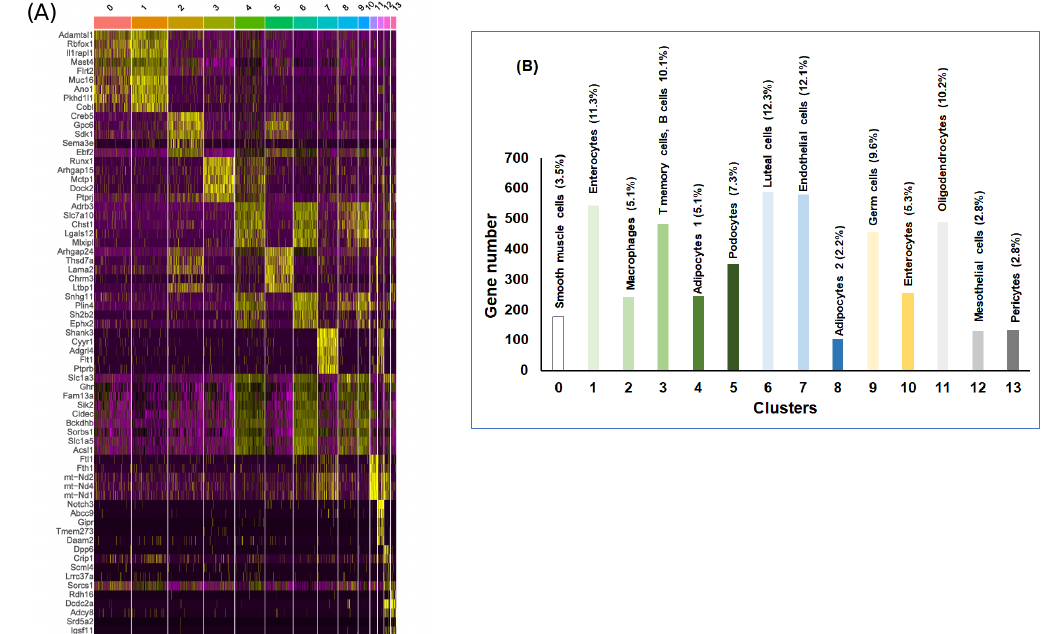
Figure 2. snRNA-seq for the statistically significant differentially expressed genes (DEGs) in vWAT of mice exposed to RA vs. IH for 6 weeks. ( A ) Heatmap of the 5 most differentially expressed genes (DEGs) of all 14 cell clusters. Each row of this heatmap is a gene determined to be a marker for one or more clusters, and each column is a cell. The cells are grouped by cluster. Each cell type is represented by the top 5 genes ranked by false discovery rate (FDR) adjusted p -value of a Wilcoxon rank sum test between the average expression per cluster value for each cell type (RA) against the other average subject expression of the other cell types for IH. Each column represents the average expression value for one cell type in RA vs. IH, n = 2/condition. ( B ) Histogram illustrates the gene number, percentage and cell types per cluster in DEGs in RA and IH. The heatmap shows the upregulated genes (ordered by decreasing p -value) in each cell type and selected enriched genes used for biological identification of each cluster (scale: Log 2 fold change). Yellow color indicates the top 5 genes for each cell